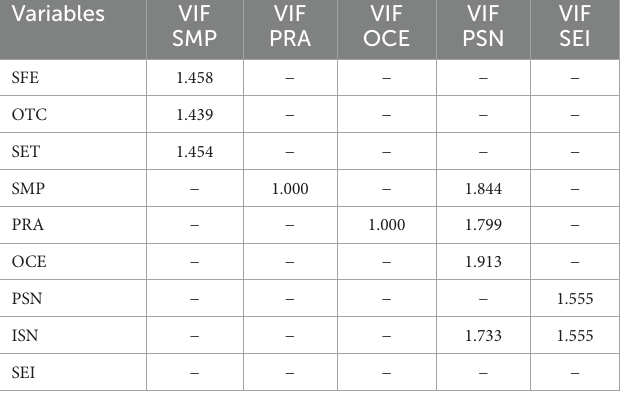
TABLE 3 Multicollinearity